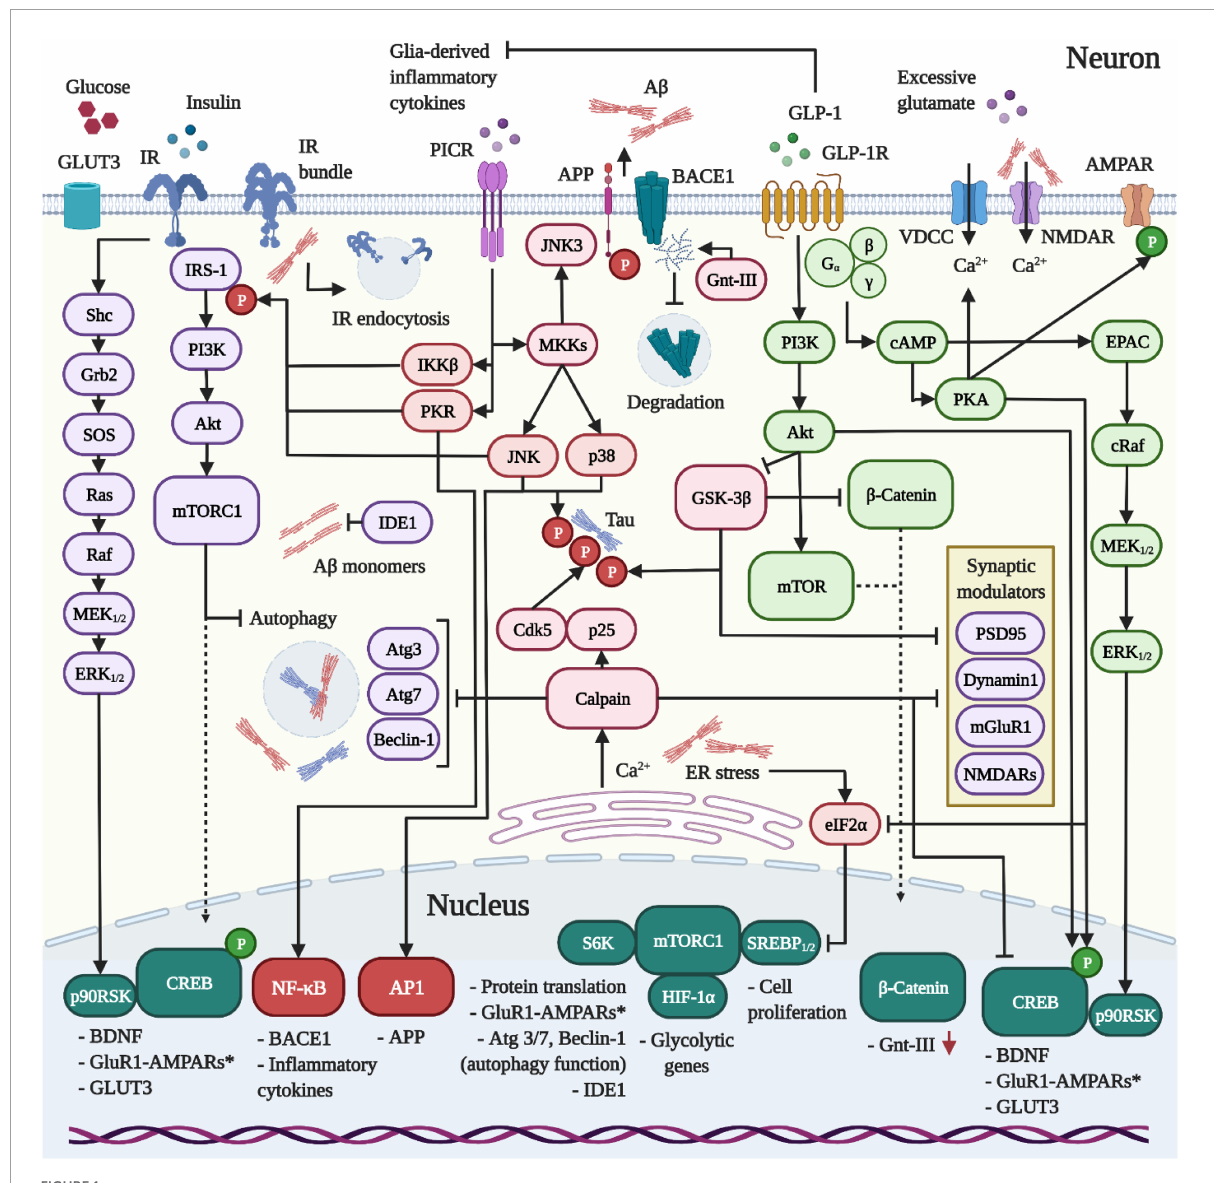
FIGURE1 Dynamics between IR, GLP-1R and PICR-signaling in neurons. 1 The release of pro-inflammatory cytokines and the activation of PICRs on neurons induce the kinases IKK β , PKR, and JNK to trigger the inhibitory Ser-phosphorylation of IRS-1 and neuronal insulin resistance in AD and PD. A β was further shown to drive IR clustering and endocytosis. In addition, A β provokes intracellular Ca 2 + accumulation by external (VDCCs/NMDARs) and internal means (ER). The latter reinforces the desensitization of the insulin pathway, blocks protein translation (eIF2 α /mTORC1 pathway) and activates the Ca 2 + -sensitive calpain to impair autophagy, interfere with the synaptic function and promote the hyperphosphorylation of Tau by cleaving p35 into the Cdk5-activating binding partner p25. Further consequences of inflammation and insulin resistance include reduced IDE1 expression, enhanced APP and BACE1 expression, A β overproduction and amassment, the loss of neuroprotective PI3K/Akt and CREB signaling, GSK-3 β hyperactivity and concomitant Tau hyperphosphorylation. Crucially, the impairment of the Akt/mTor pathway following insulin resistance impedes the expression of glycolytic enzymes, thus enforcing bioenergetic impairments and glucose hypometabolism. 2 In contrast to the IR, the GLP-1R does not desensitize in neurons. When activated, the GLP-1R stimulates PI3K/Akt/mTORC1, cAMP/PKA, MEK/ERK, and CREB/BDNF-signaling to ameliorate the A β (section “GLP-1R agonists are neuroprotective and prevent amyloid beta accumulation in vivo” ) and Tau (section “GLP-1R mimetics suppress Tau hyperphosphorylation and aggregation during AD”) pathologies through various mechanisms, suppress excessive Ca 2 + influx and ER stress (not shown; details in sections “GLP-1 mimetics suppress Ca2+ deregulation by amyloid beta and excitotoxicity” and “GLP-1 analogues counteract endoplasmic reticulum stress”), restore insulin signaling (section “Insulin resistance and the neuronal energy metabolism”) by aiding the clearance of A β , normalize the autophagy function by raising the expression of autophagy modulators via mTORC1 (Atg3, Atg7, Beclin-1) (section “Autophagy and mitophagy”), elevate neurogenesis (section “GLP-1R agonists promote neurogenesis”) and promote the synaptic function, plasticity and memory (section “Pro-cognitive effects”). Importantly, the activation of GLP-1R on microglia and astrocytes induces the anti-inflammatory M2 phenotype and suppresses inflammatory cytokine production (not shown; see section Inflammation), thus preventing insulin